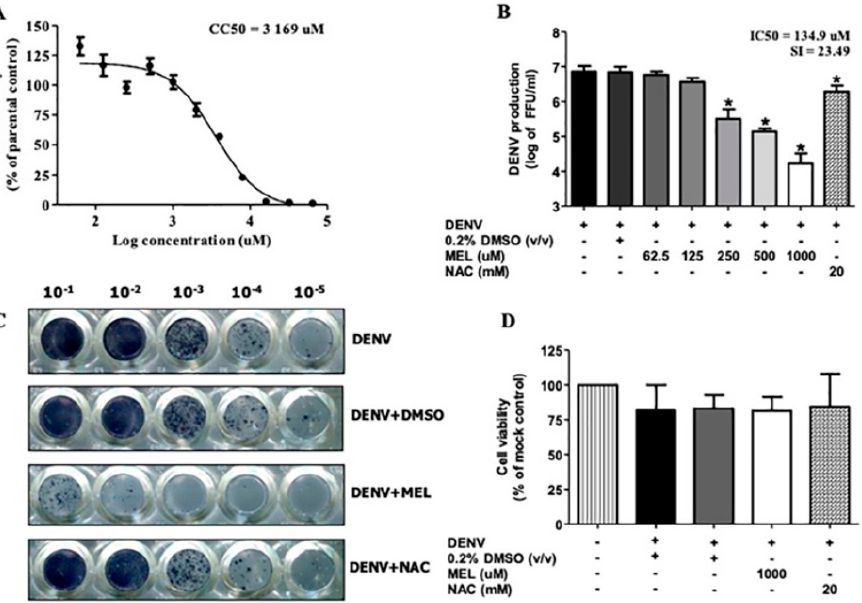
Figure 1. Antiviral effect of melatonin (MEL) on dengue virus (DENV2)-infected Huh7 cells. ( A ) Huh7 cells were inoculated with MEL in a 2-fold serial dilution for 24 h. Cell viability was measured by Presto Blue assay and the result was plotted into a graph, displaying the cytotoxic concentration (CC 50 ). ( B ) Huh7 cells were infected with DENV2 at multiplicity of infection (MOI) 1 and treated with MEL at various concentrations. Culture supernatant were collected at 24 h pi and FFU assay was performed. ( C ) Representative picture for focus-forming unit (FFU) assay from one of the three independent experiments using 1000 µ M MEL and 20 mM N-acetyl cysteine (NAC). ( D ) Cell viability was checked for the same time point. The asterisk (*) sign denotes p < 0.05 considered to be statistically